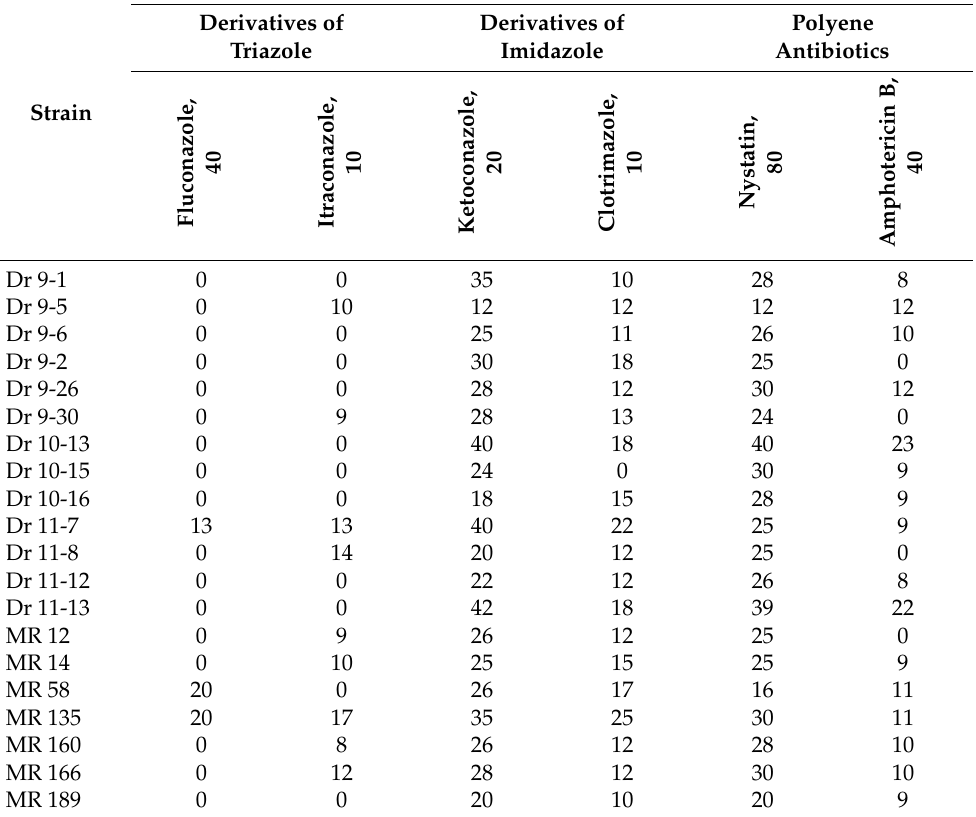
Table 5. Sensitivity of fungi isolated from studied aerosol samples to antimycotic drugs. Antibiotic, Amount on Disk, µ g/Diameter of Zone of Growth Inhibition,